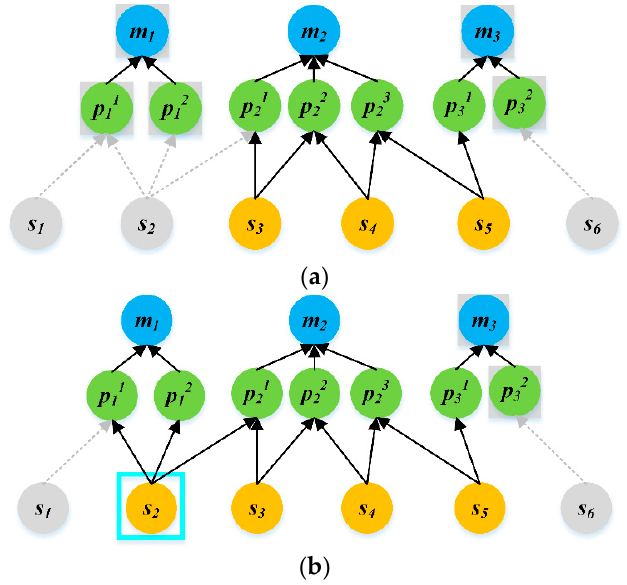
Figure 3. Disruption and recovery of suppliers: ( a ) Disruption of suppliers; ( b ) Recovery of suppliers.